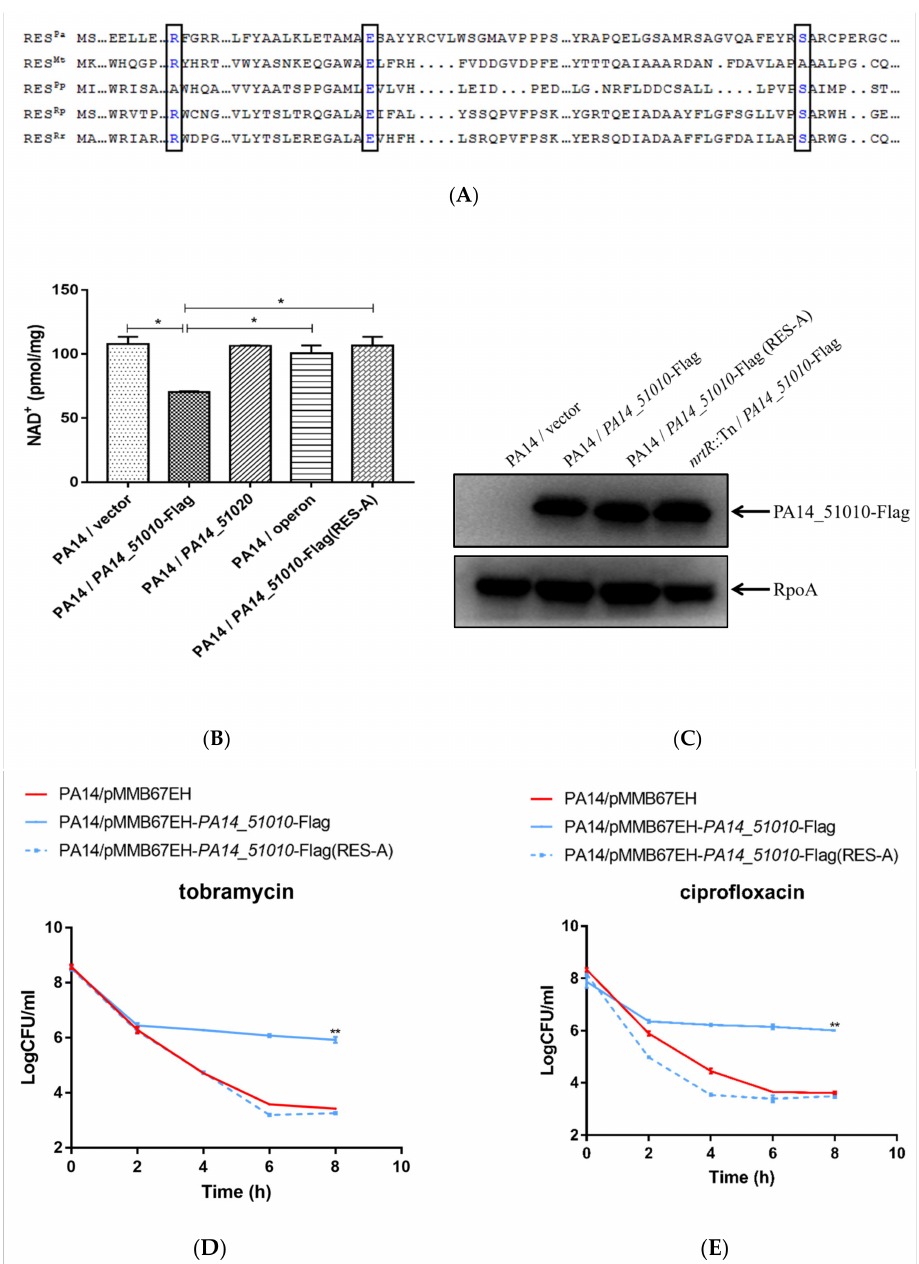
Figure 5. PA14_51010 promotes persister formation by reducing intracellular NAD + . ( A ) Protein sequence alignment of RES toxins from PA14 (RES Pa ), M. tuberculosis (RES Mt ), Pseudomonas putida KT2440 (RES Pp ), Rhodopseudomonas palustris BisB18 (RES Rp ) and Rhodospirillum rubrum ATCC 11170 (RES Rr ) by Dnaman. The conserved residues are shown in blue and boxed. ( B ) Wild-type PA14 carrying pMMB67EH, pMMB67EH- PA14_51010 , pMMB67EH- PA14_51020 , pMMB67EH-operon or pMMB67EH- PA14_51010 (RES-A) were cultured in LB to an OD 600 of 1.0. The bacteria were collected by centrifugation, washed three times with phosphate buffered saline (PBS), and then lysed in an NAD + extracting buffer by sonication. The relative quantity of NAD + was normalized by the corresponding total protein amount. **, p < 0.01 by Student’s t test. ( C ) The levels of the PA14_51010-Flag in PA14/vector, PA14/ PA14_51010 -Flag, PA14/ PA14_51010 -Flag (RES-A) and nrtR ::Tn/ PA14_51010 -Flag. ( D , E ) Wild-type PA14 carrying pMMB67EH, pMMB67EH- PA14_51010 or pMMB67EH- PA14_51010 (RES-A) were treated with 5 µ g/mL tobramycin ( D ) or 0.5 µ g/mL ciprofloxacin ( E ). At indicated time points the live bacteria numbers were determined by serial dilution and plating. Data represent the results from three independent experiments. *, p < 0.05; **, p < 0.01 compared to the other samples by Student’s t